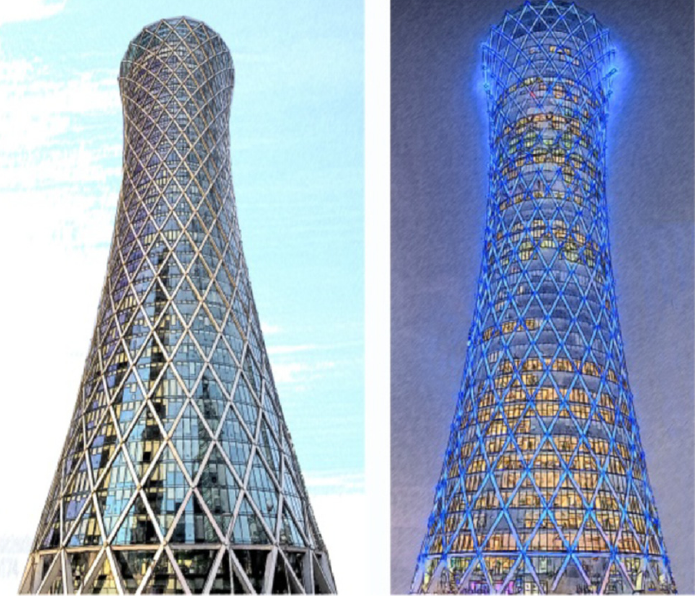
Figure 22. The Tornado Tower (2008) in Doha, Qatar, daytime ( left ), nighttime ( right ). (Sketch by K. Al-Kodmany).